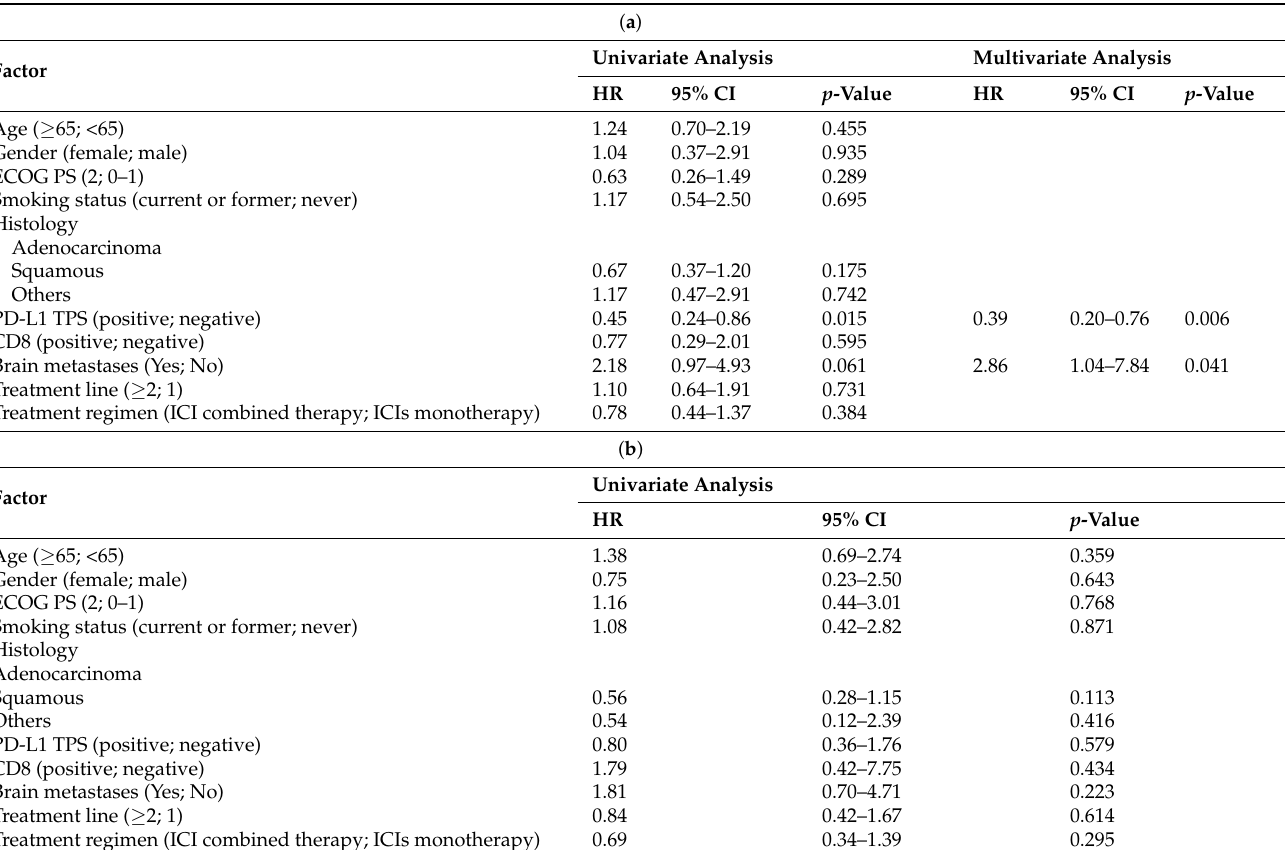
Table 4. Univariate and multivariate analysis of progression-free survival and overall survival in relation to the baseline characteristics of included NSCLC patients with liver